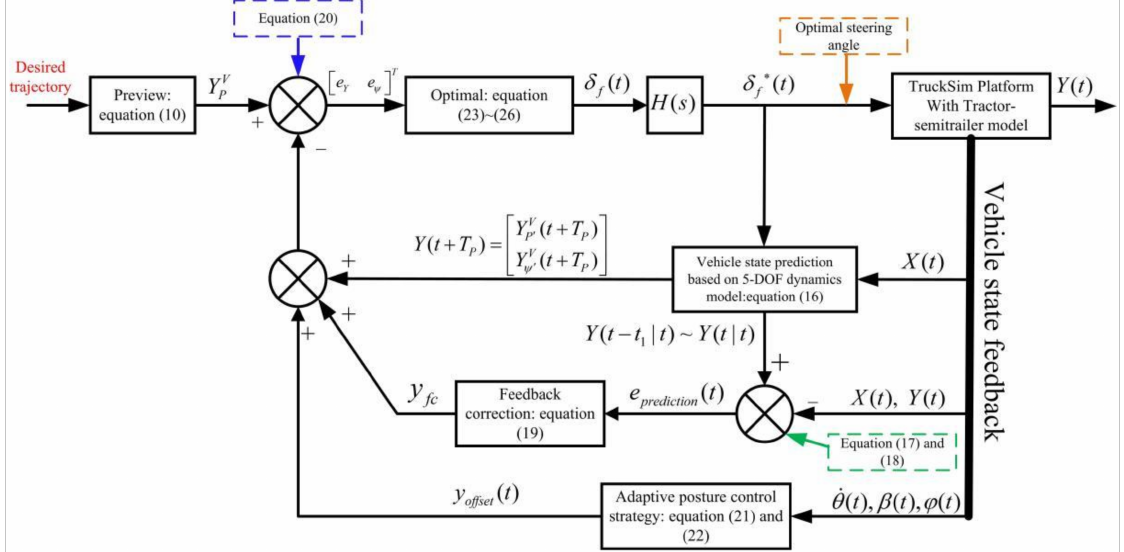
Figure 2. Overall block diagram of